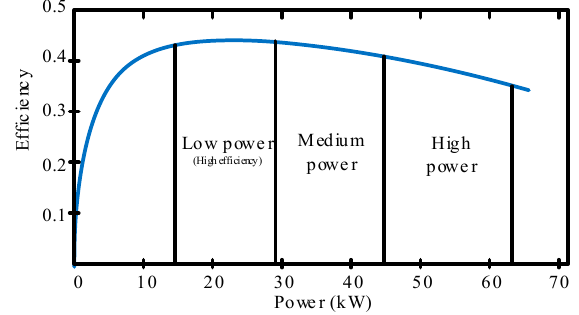
Figure 5. Fuel cell efficiency versus power.